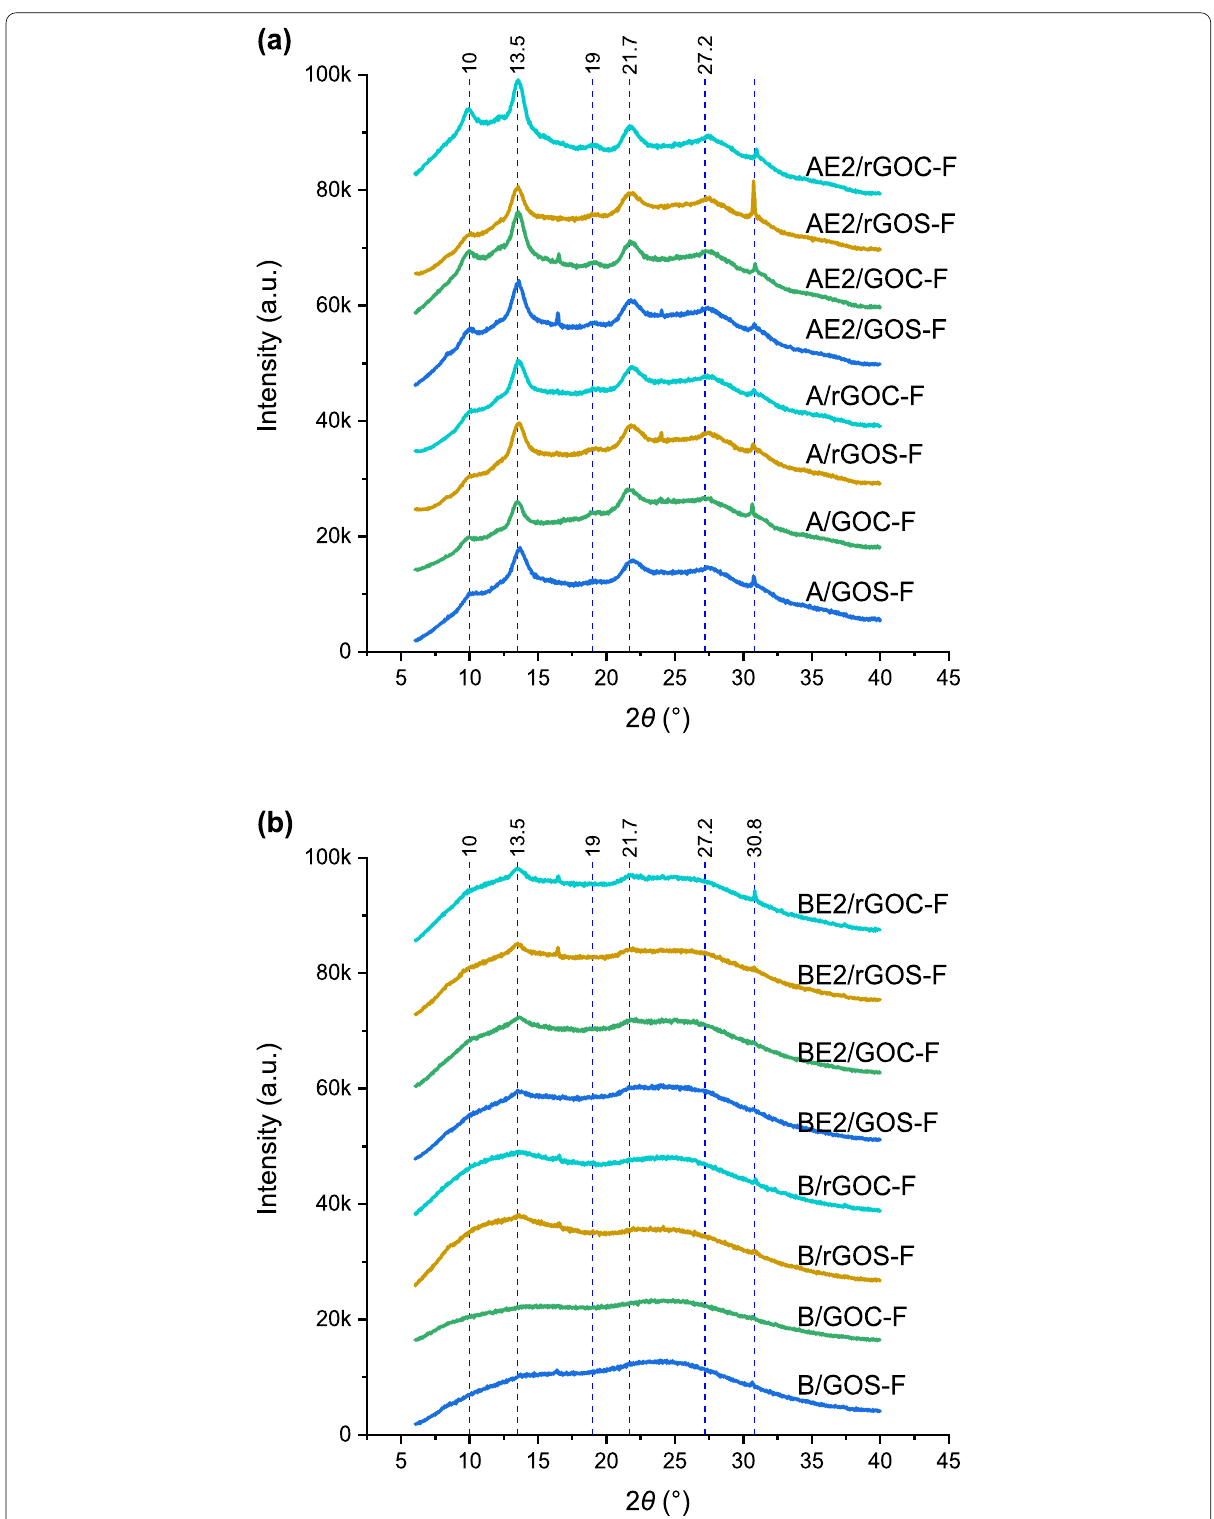
Fig. 3 X-ray diffractograms for the different a chitosan and b chitosan/carboxymethyl cellulose (CMC)-based nanocomposite